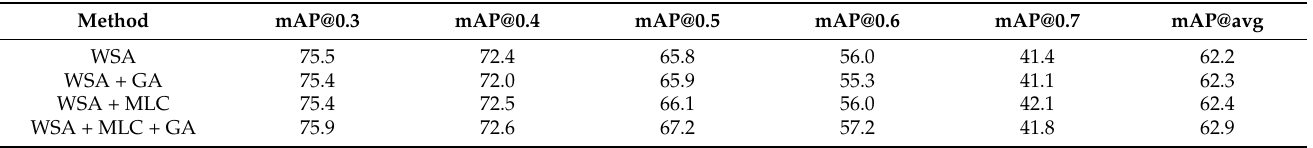
Table 7. Ablation study of complementarity on THUMOS14 in terms of